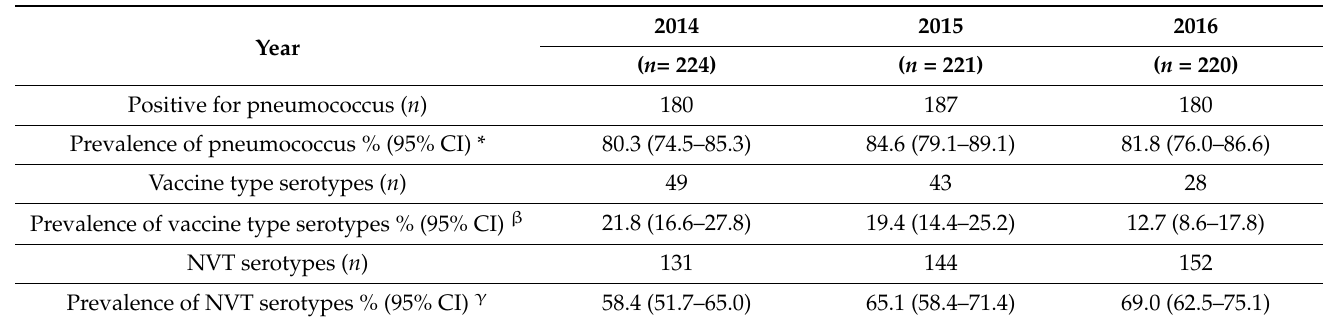
Table 2. Vaccine type and non-vaccine type (NVT) carriage across three surveys in children 3–12 months of age in Matiari, Pakistan.